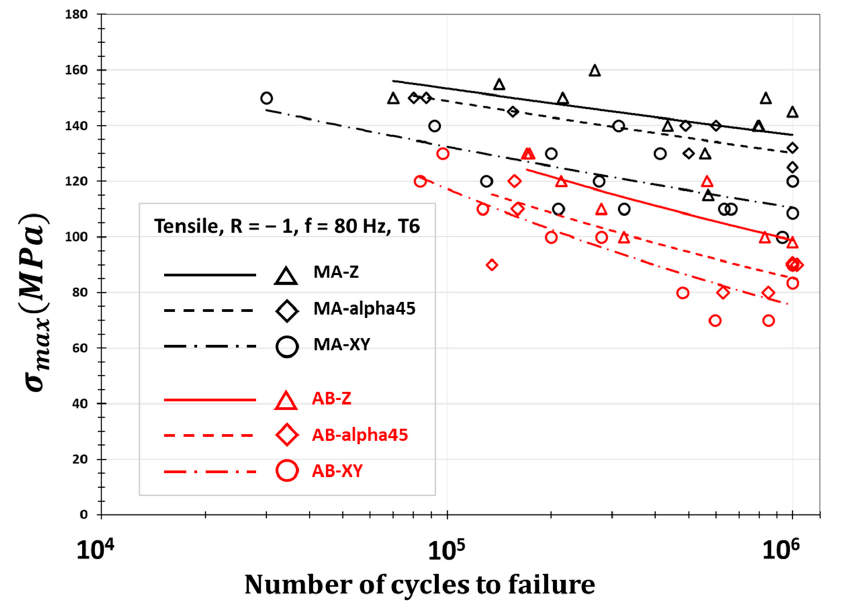
Figure 5. Influence of as-built surfaces and building direction; T6 heat treated material (AB: As-Built; MA: machined [14]); 10 6 : run-out samples. Metals 2021 , 11 , x FOR PEER REVIEW